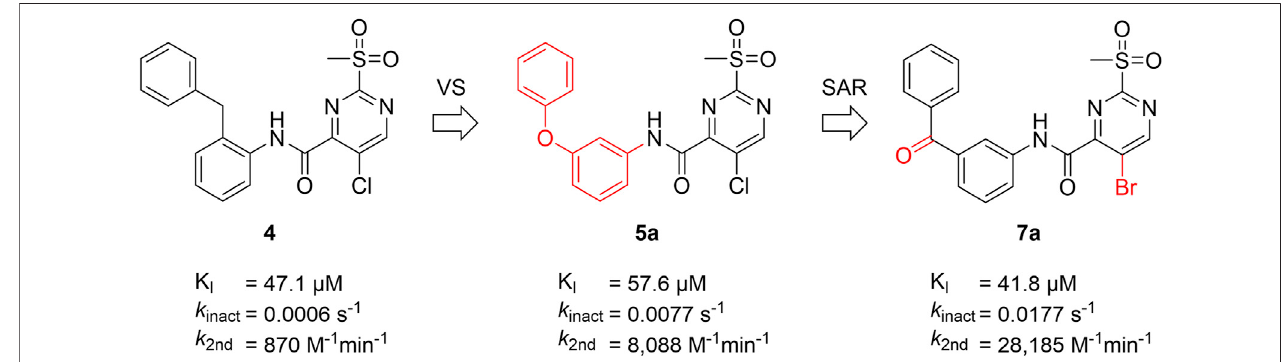
FIGURE 4 | Summary of ligand optimization. Summary and inhibition data of the optimization strategy starting from literature compound 4 via virtual screening hit 5a to yield lead structure 7a